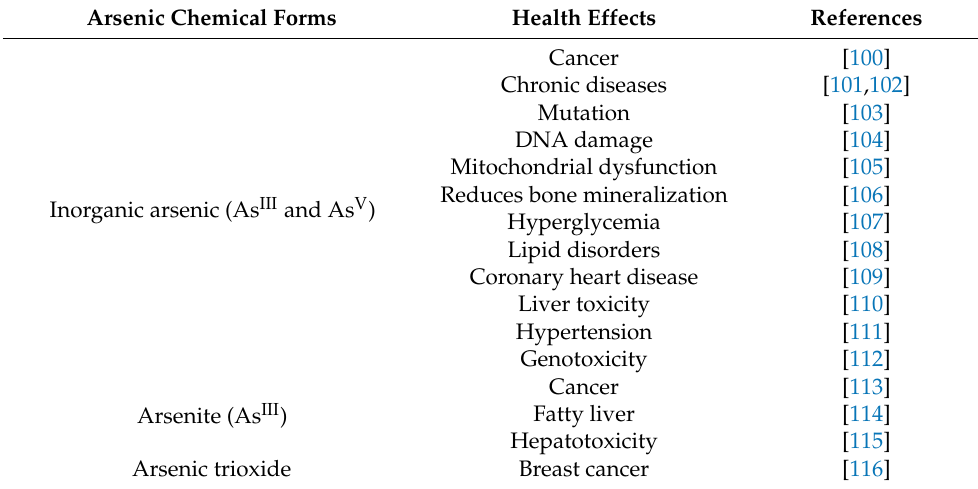
Table 4. Various arsenic species and associated health